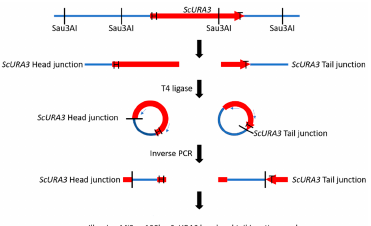
Figure 1. Construction of ScURA3 head (arrow, labeled H) and tail (labeled T) junction libraries. DNA from a ScURA3 transformant clone is cleaved at GATC sites with Sau3AI and the fragments are ligated under dilute conditions to yield DNA circles with separate ScURA3 head and tail junctions. The ligated DNA is then divided into two aliquots. Circles containing the head junctions are amplified in a PCR reaction with primers ura3 + 61c and ura3 TestF. The tail junctions are amplified with ura3 + 720c and ura3 R1-1-DN primers. The result is separate head and tail junction